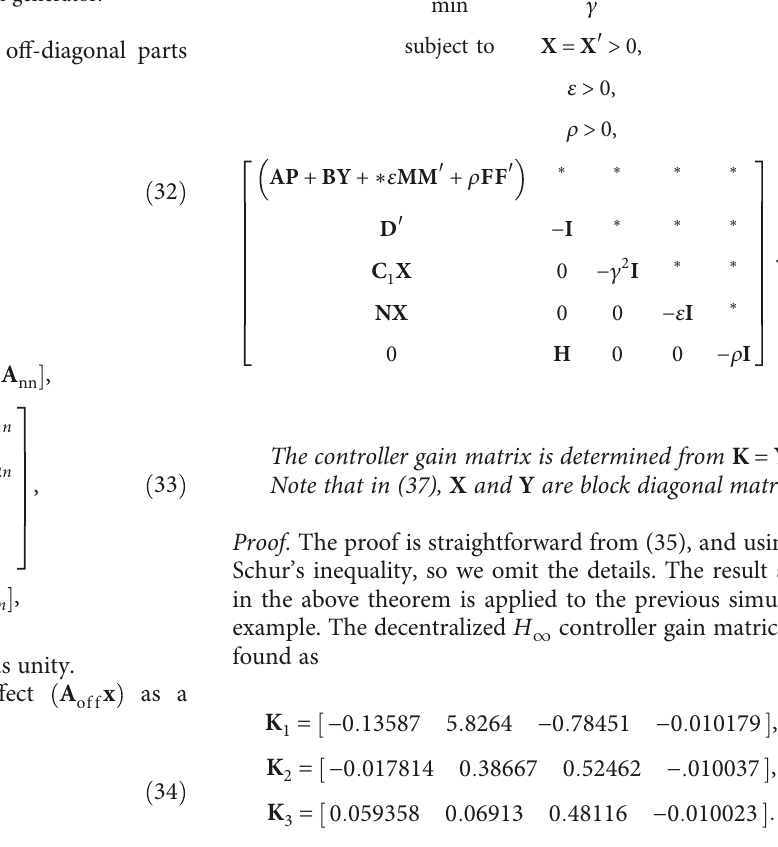
Figure 3: The control signal for each